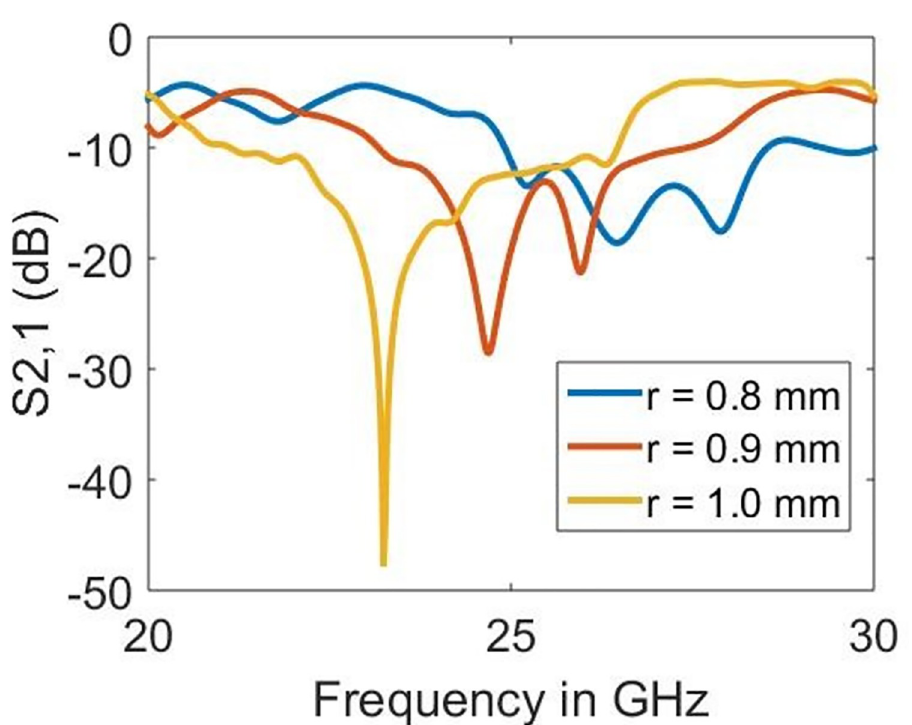
Fig 6. Effect of the radius on the resonance frequency.